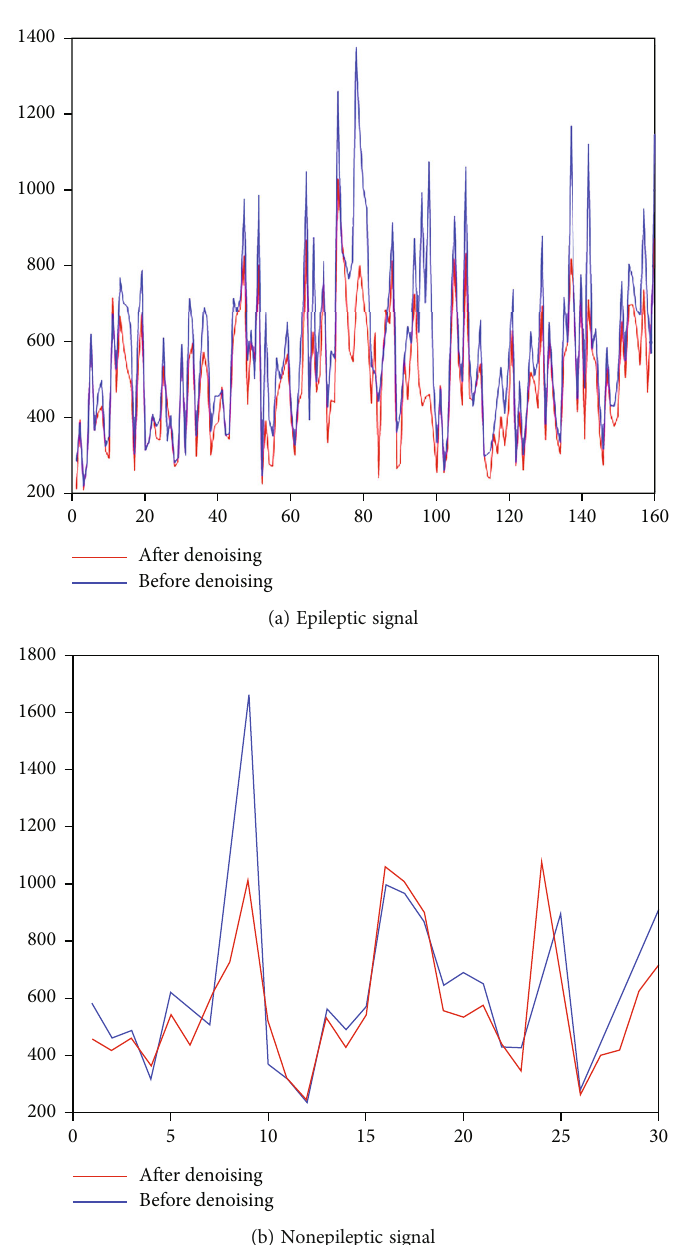
Figure 8: Trend of mean PSD.